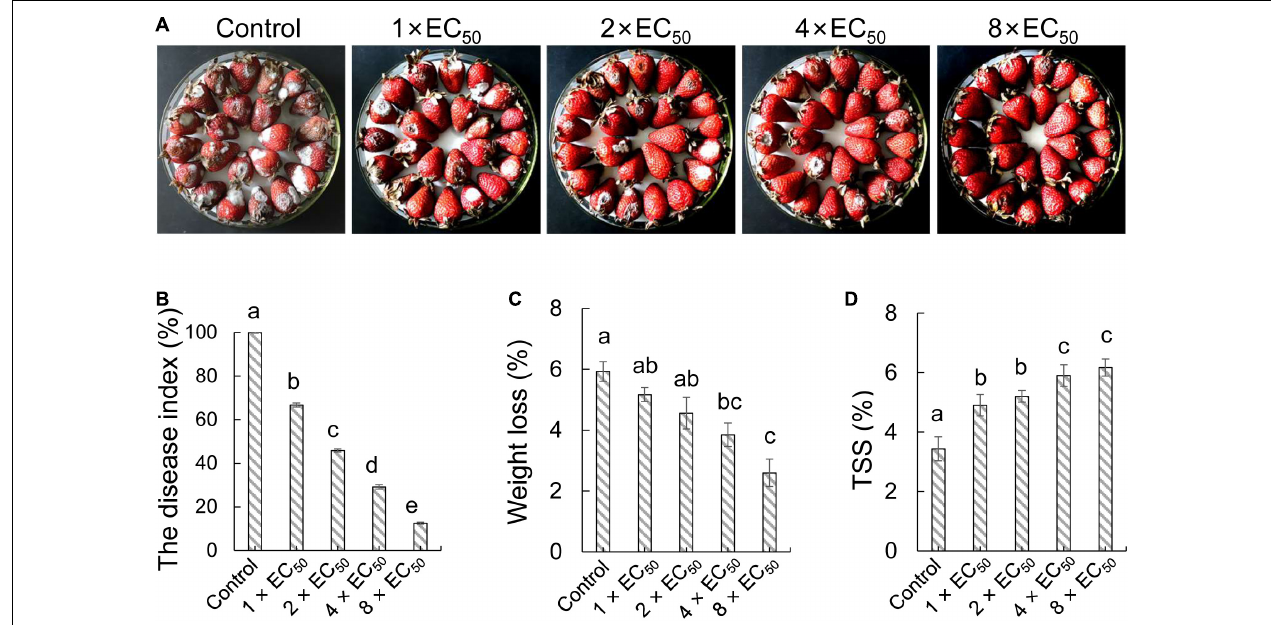
FIGURE 4 | In vivo effects of strain QN1NO-4 extract on fruit decays and disease incidence caused by C. fragariae . (A) Disease inhibition of extract on strawberry fruit. Four extract concentrations (1 × EC 50 , 2 × EC 50 , 4 × EC 50 , and 8 × EC 50 ) were selected. The treated fruit samples were stored at 28 ◦ C for 7 days. (B) Quantitative analysis of disease incidence of strawberry fruit treated with different dose extracts. (C) Effects of strain QN1NO-4 extract on weight loss of strawberry fruit. (D) Effects of strain QN1NO-4 extract on TSS contents of strawberry fruit. Error bars indicated standard errors of the means of three repeated experiments. Different letters indicated a significant difference ( p < 0.05) among different dose extracts using the LSD multiple-range test.